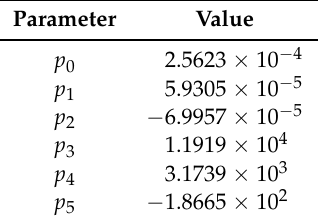
Table 1. Coefficients for the New Atmospheric Transmissivity